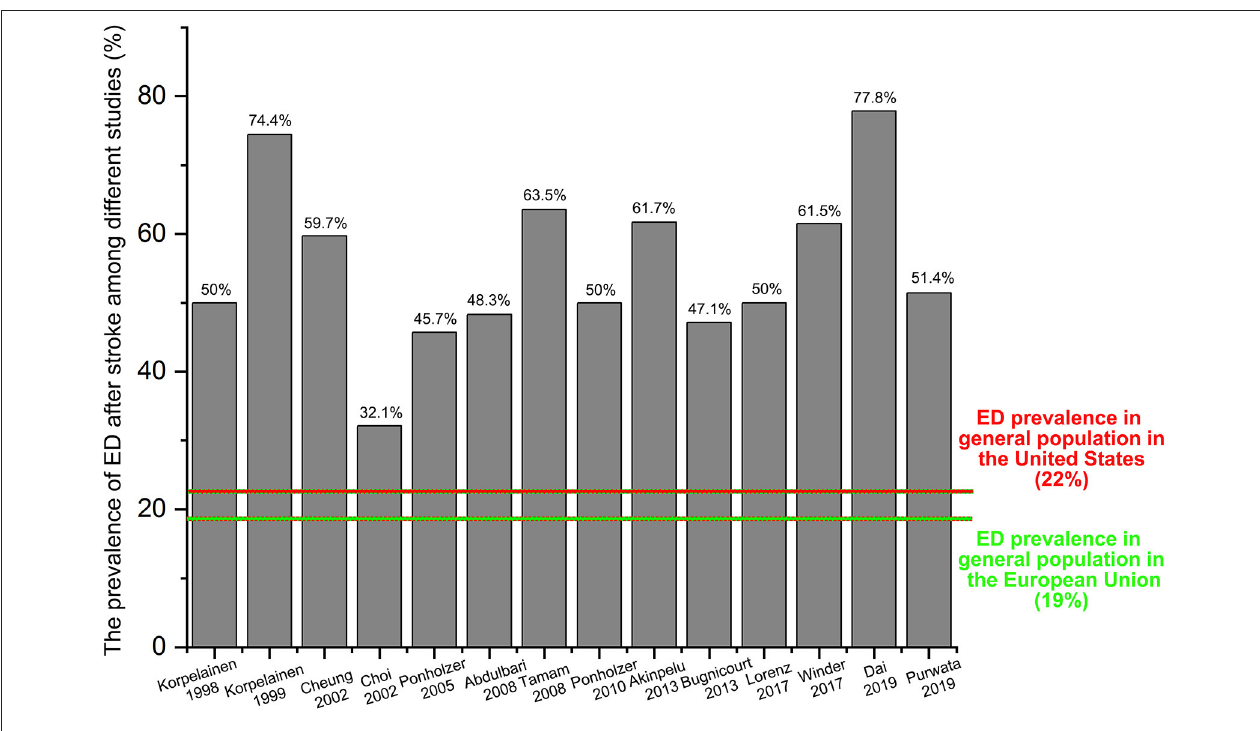
FIGURE 4 | Crude ED prevalence of the 14 included studies.